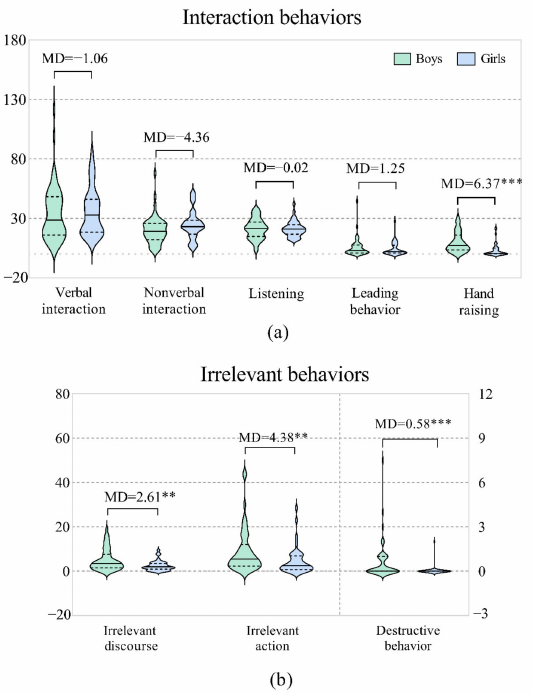
Figure 2. Differences in gender. ( a ) Interaction behaviors: the frequencies of verbal and nonverbal interactions are reflected on the left Y axis; the frequencies of behaviors of listening, leading, and hand raising are reflected on the right Y axis. ( b ) Irrelevant behaviors: the frequencies of irrelevant discourse and irrelevant action are reflected on the left Y axis, and the frequency of destructive behavior is reflected on the right Y axis. Note: **: p < 0.01; ***: p <